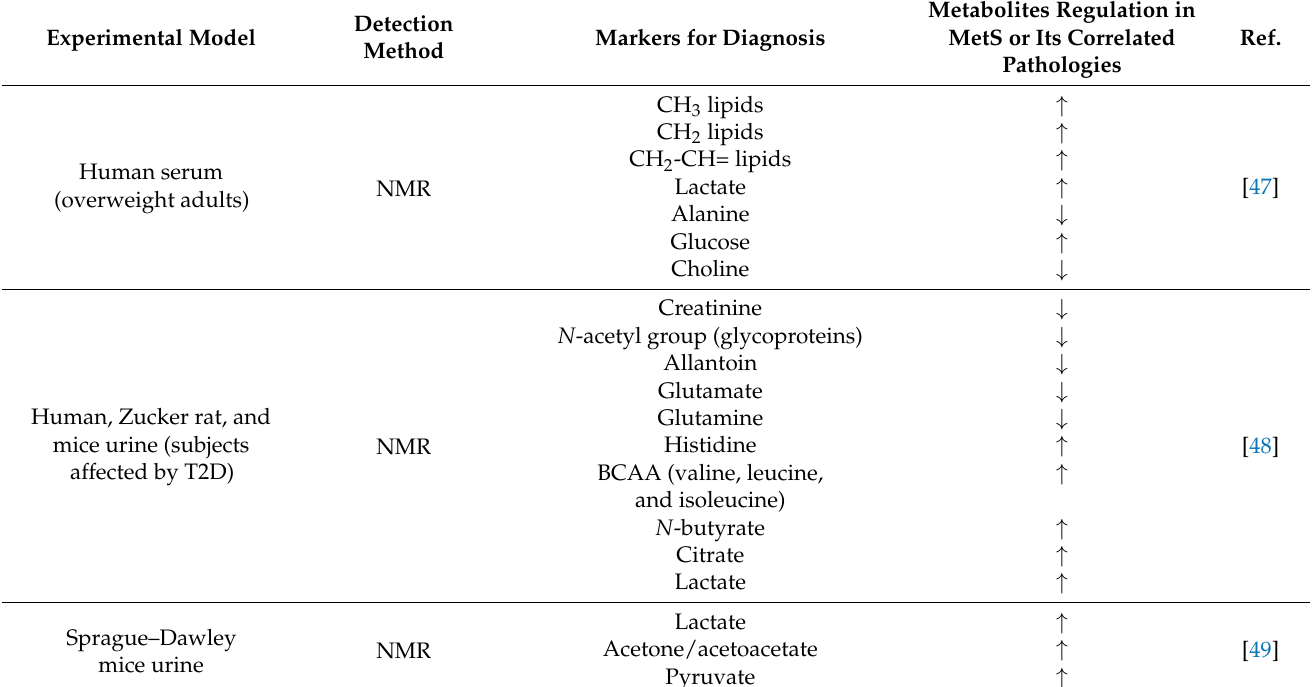
Table 1. Summary description of studies discussed regarding MetS-related pathologies and predictive methods for diagnosis. The experimental model, method, markers for diagnosis, and metabolites regulation are described.